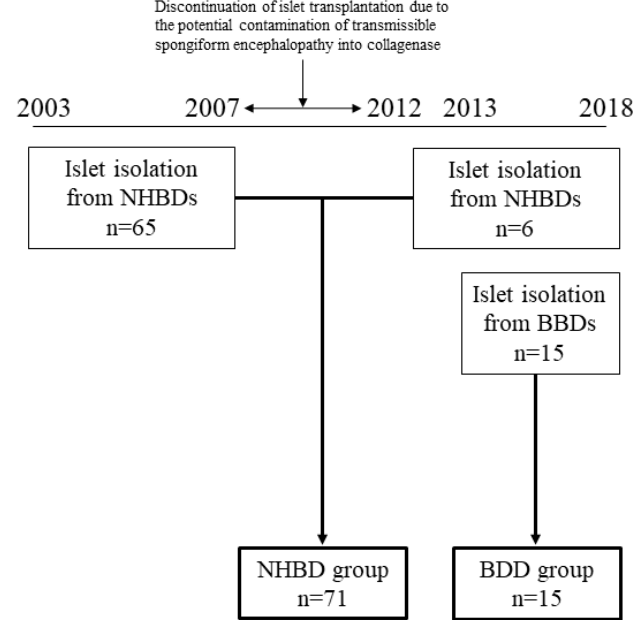
Figure 1. A flow chart of enrolled cases into the non-heart-beating donors (NHBD) and brain-dead donors (BDD) groups for comparison of islet isolation results. The islet isolation results donated from NHBDs in 2003–2007 and 2012–2018 have combined into the NHBD groups, while BDD groups have included the islet isolation results donated from BDDs only since 2003 when pancreases utilization has started for islet transplantation.